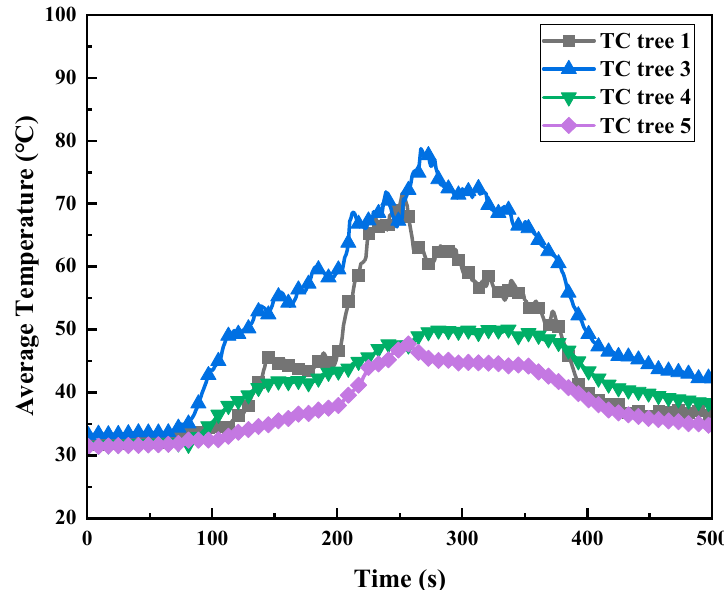
Figure 8. Temperature changes at different positions in the cabin ( V s = 2.058 m 3 /s ) .